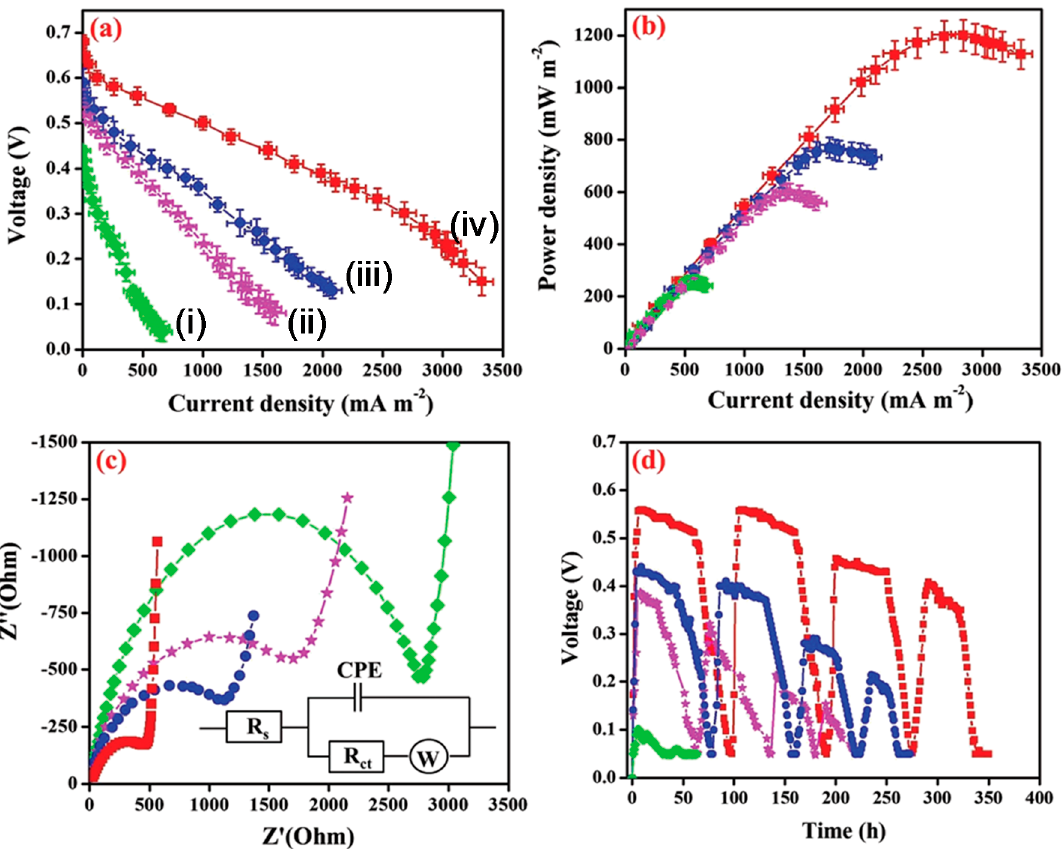
Figure 5. ( a ) Polarization and ( b ) power density curves (error bars indicate the standard deviation acquired from three microbial fuel cell (MFC) experiments), ( c ) electrochemical impedance spectroscopy (EIS) analysis, Inset: depicting the equivalent circuit used for fitting the EIS data, and ( d ) durability performances of MFCs with (green dots) bare Biochar (BC) anode (i), (violet dots) Fe 3 O 4 /BC (ii), (blue dots) NiFe 2 O 4 /BC (iii), and (red dots) PEDOT/NiFe 2 O 4 (1:2)/BC (iv) [101]. (ii), (blue dots) NiFe 2 O 4 / BC (iii), and (red dots) PEDOT / NiFe 2 O 4 (1:2) / BC (iv) [101].